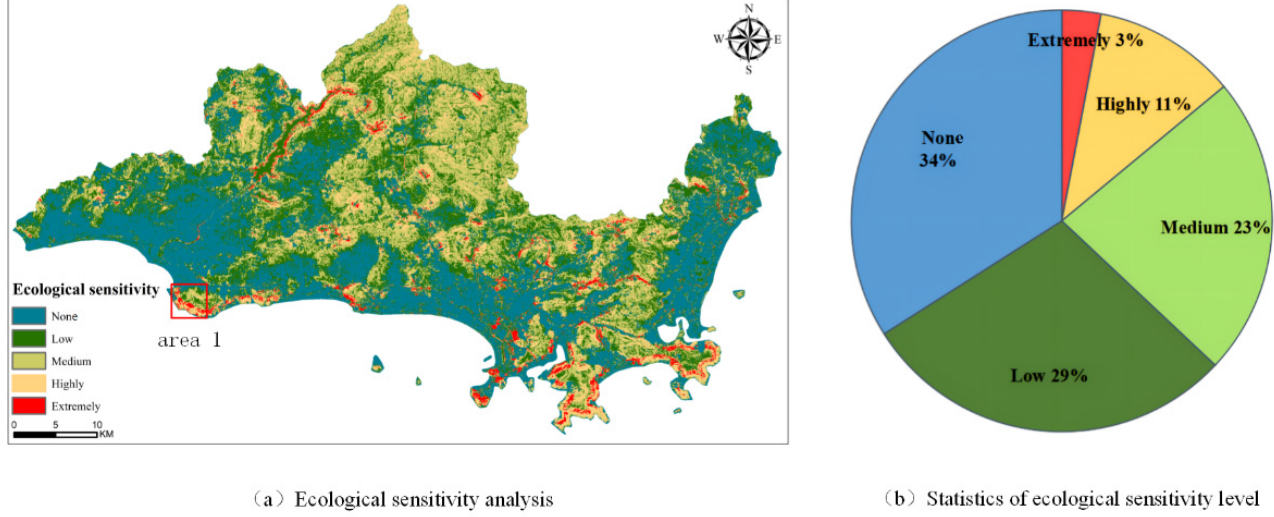
Figure 4. Ecological sensitivity analysis and results statistics.